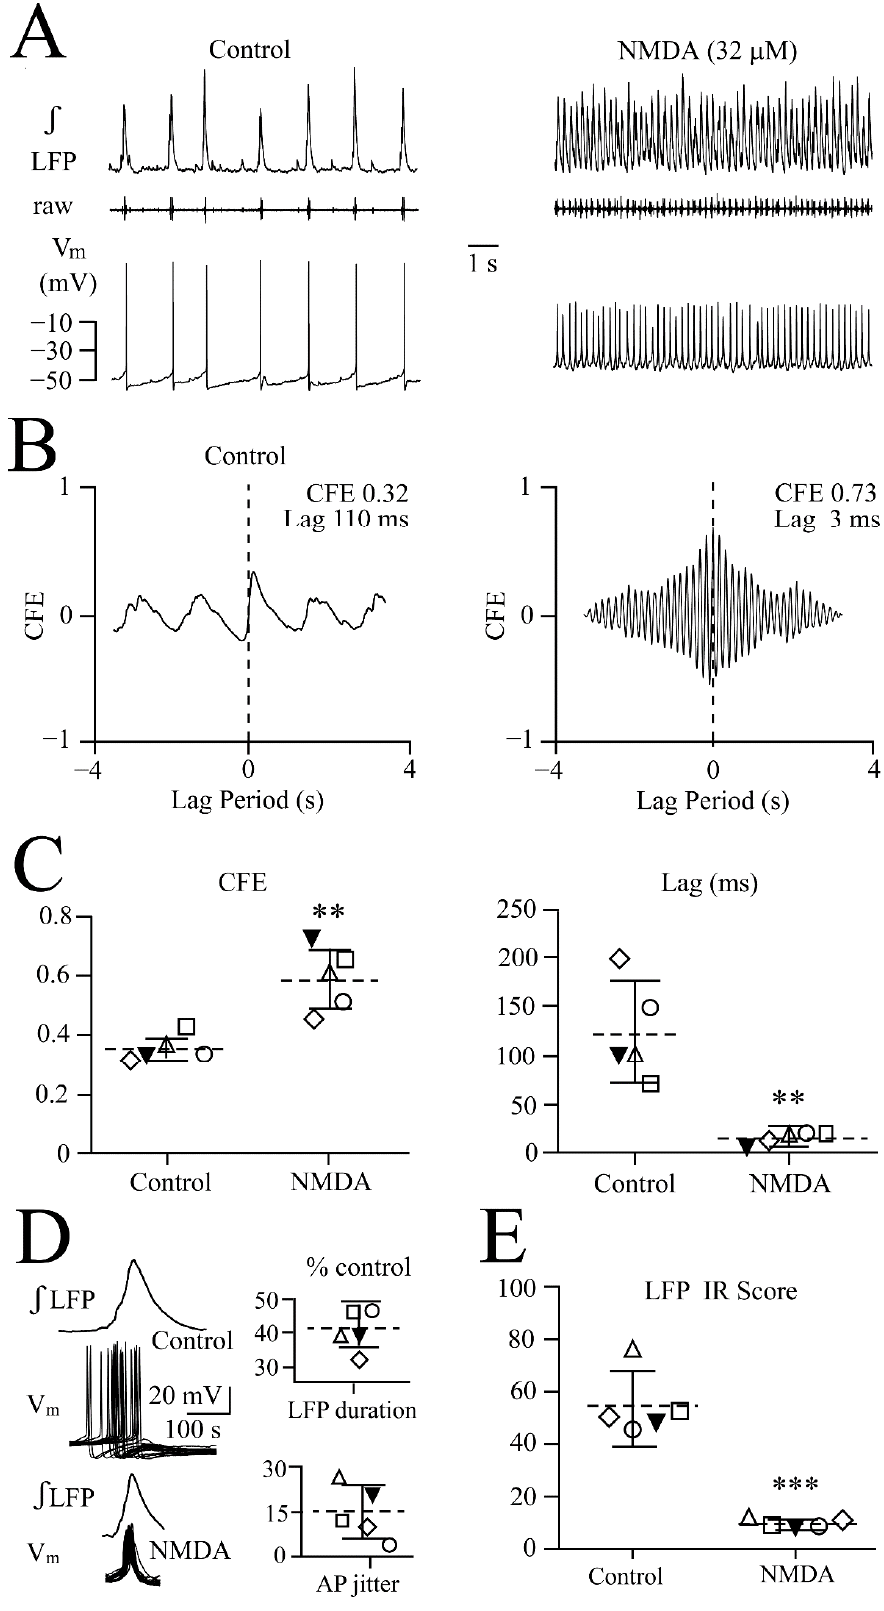
Figure 7. Cross-correlation of synchronizing NMDA effects. ( A ) Shows the ‘early’ LFP pattern transformation to faster oscillations in 32 µ M NMDA. In the simultaneously recorded neuron,